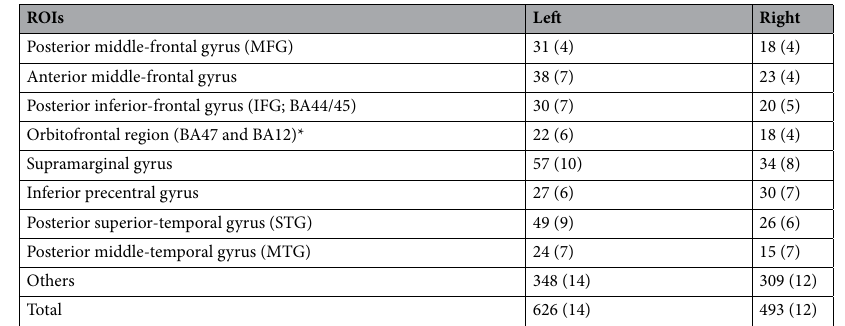
Table 2. The number of electrodes at regions of interest (ROIs). The total number of analyzed electrode sites (and the number of contributing patients) in each ROI is provided. The Desikan FreeSurfer Atlas was used to define ROIs in the present study 8,66 . BA Brodmann area. *The orbitofrontal region was defined as the summation of the pars orbitalis of the IFG and the lateral orbitofrontal gyrus.